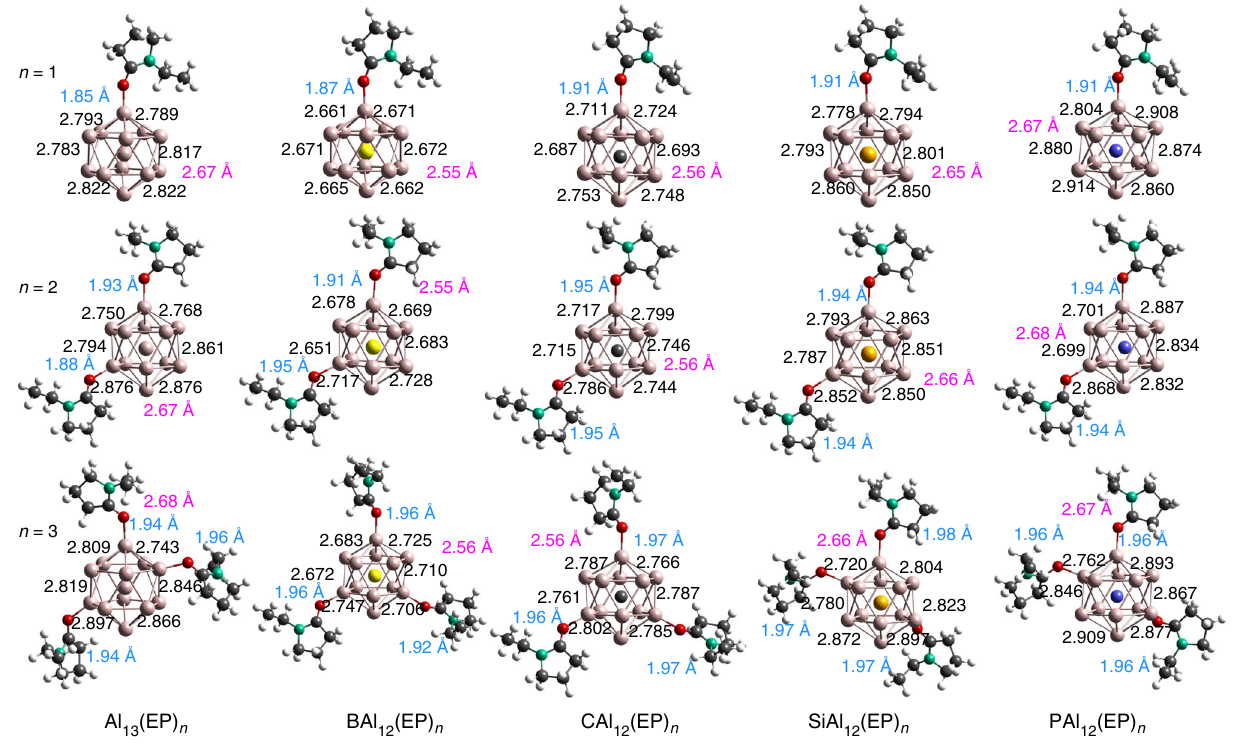
Fig. 3 Ground state structures of neutral Al 13 (EP) n and MAl 12 (EP) n (M = B, C, Si, and P) clusters where n = 1 – 3. The Al – Al bond lengths are also shown and given in Å. The average bond lengths of interior central atom to surface Al atoms are given in magenta text, while the Al – O bond lengths are given in light blue text